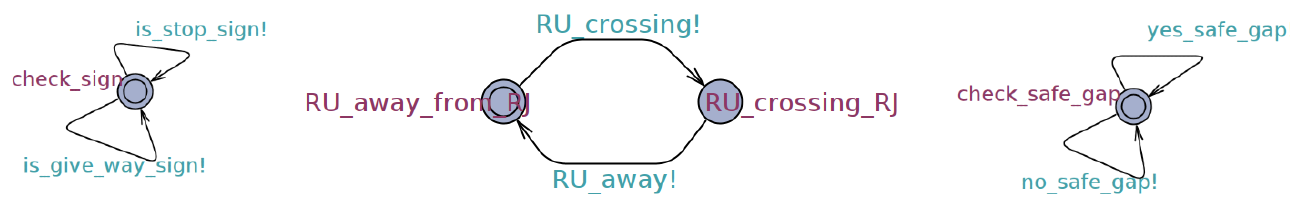
Figure 5. UPPAAL templates for the environment